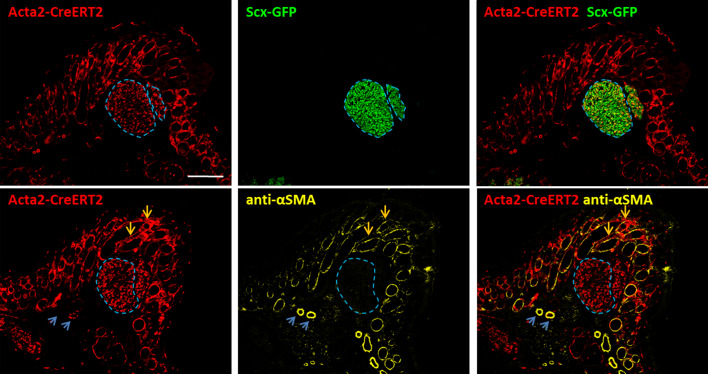
Lineage tracing with Acta2-CreERT2 show unexpected labeling in neonatal tenocytes.Tamoxifen delivered at P2, P3 with P5 harvest show extensive aSMAlin labeling in Scx-GFP+ tenocytes (blue dashed outlines). Immunostaining for αSMA showed that tenocytes do not express αSMA. Overlays show extensive aSMAlin labeling and immunostaining in hair follicles (orange arrows) while blood vessels are inconsistently labeled (green arrows).